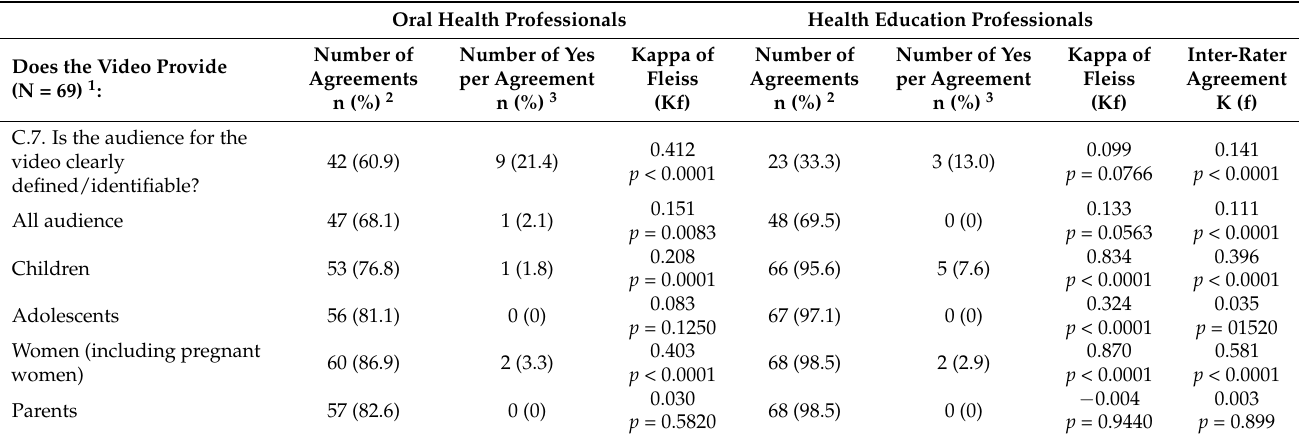
Table 4. Targeted audience by Tik Tok videos corresponding to